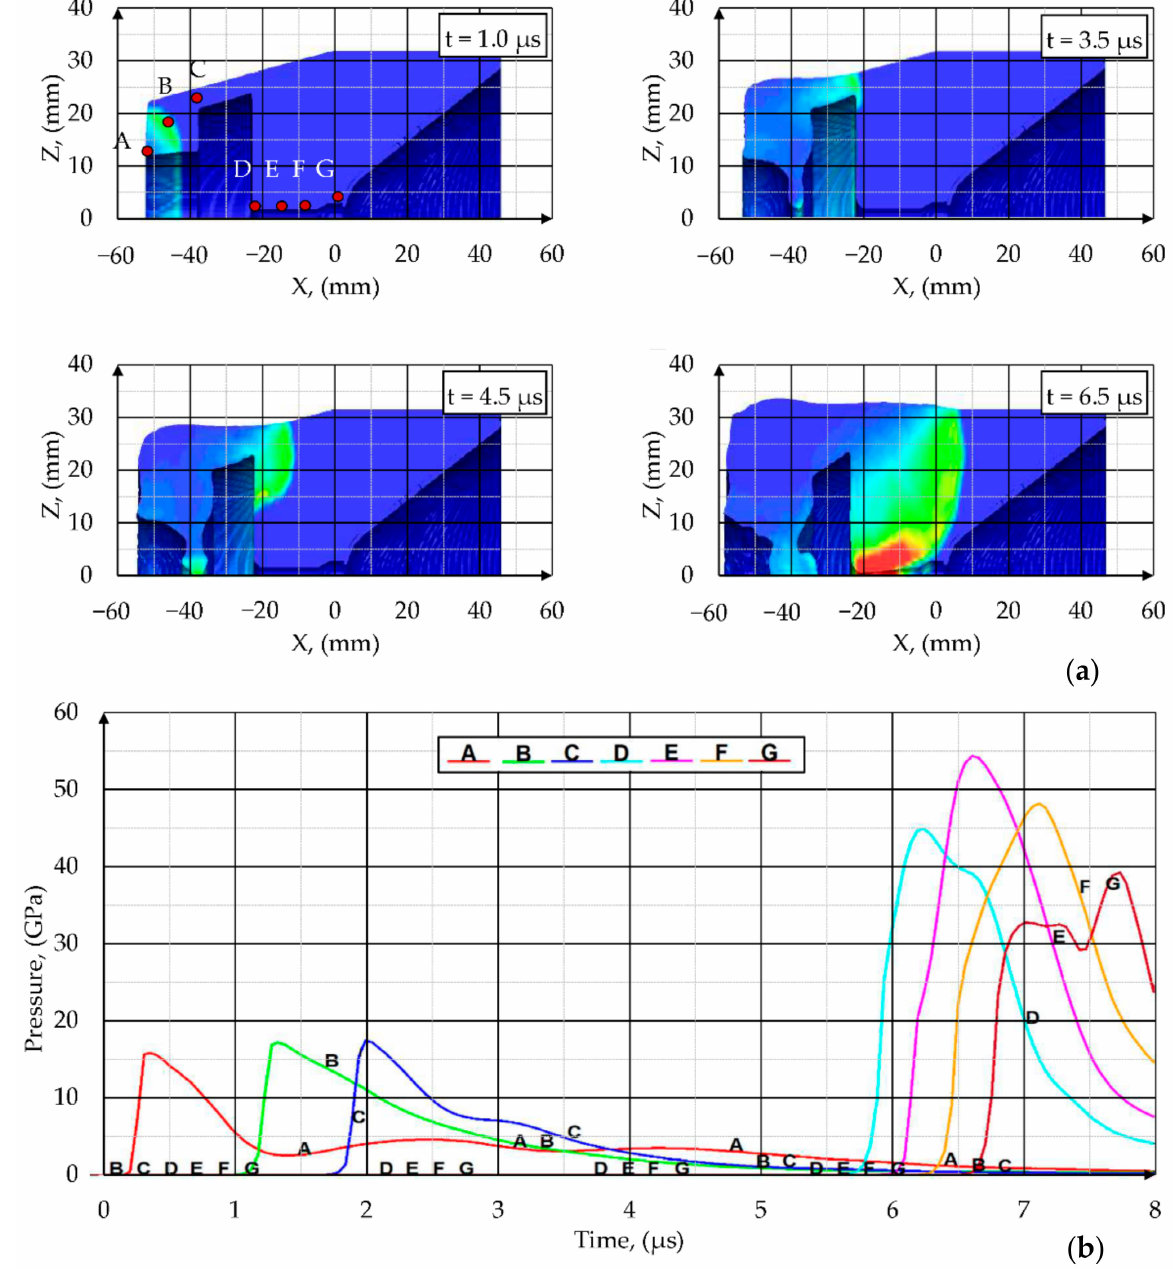
Figure 11. Propagation of the detonation wave in the PG-7VM warhead ( a ) and the pressure registered on the tracer nodes A–G ( b